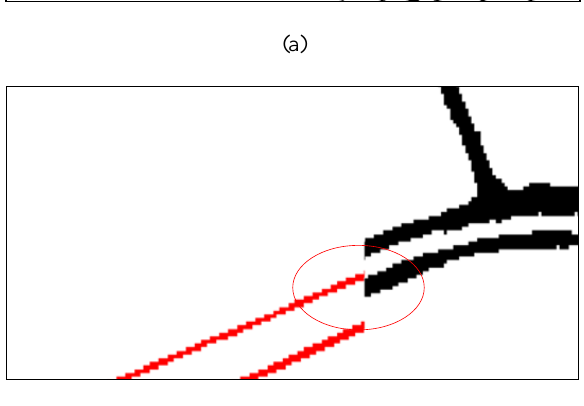
Figure 6. Results after georeferencing in an independent approach